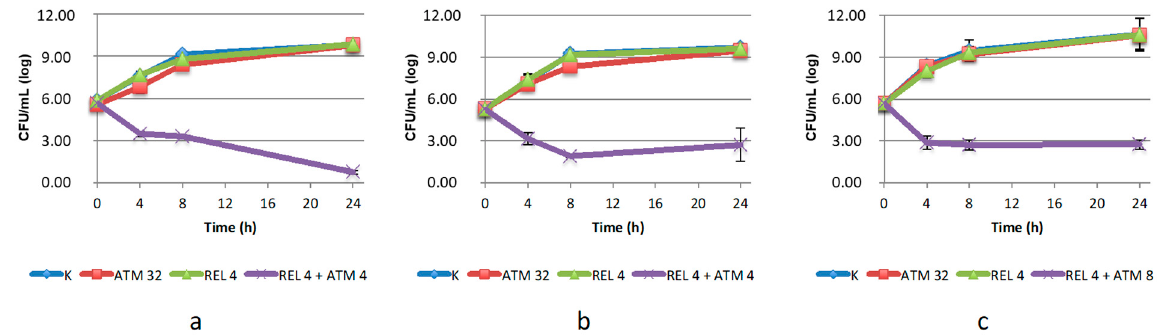
Figure 2 Figure 2. Twenty-four-hour time–kill curves of aztreonam (ATM) and relebactam (REL), alone and in combination, on: ( a ) C. amalonaticus N18; ( b ) K. pneumoniae KL 12 SG; ( c ) K. pneumoniae LC954/14. K: positive control (without the addition of antimicrobials). Mean values and standard deviation of three independent experiments are